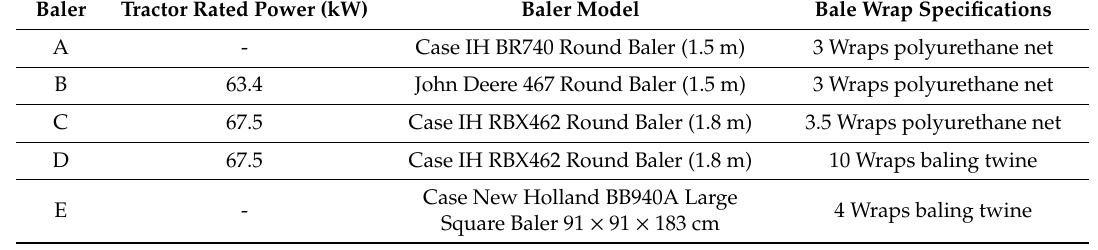
Table 2. Baler specifications.